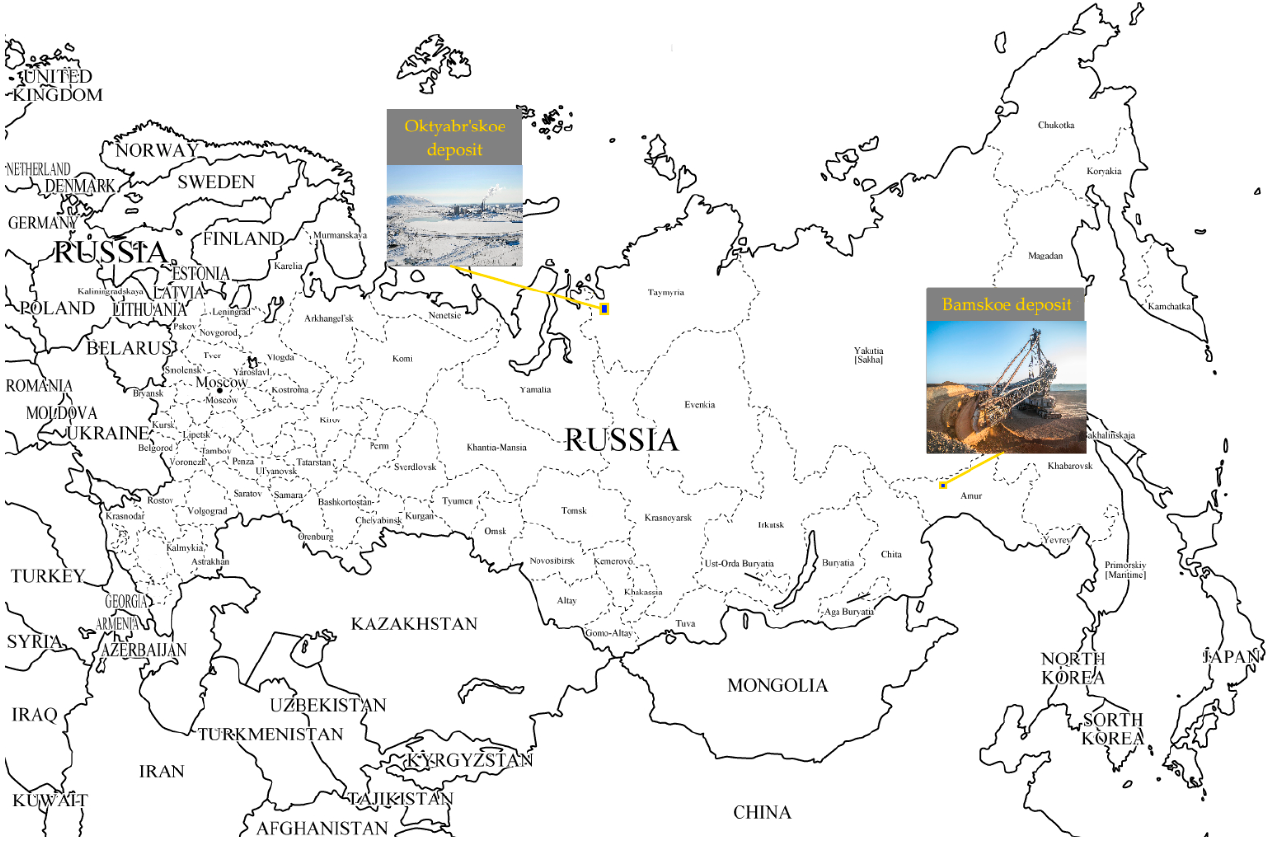
Figure 1. Location of the Bamskoe deposit and the Oktyabrskoye deposit. The samples were selected according to the following criteria: both samples are polymetallic ores. The ores of the Bamskoye deposit (Figure 2) are fine- and medium- grained from mainly vein disseminated ores.The copper-nickel ore of the Oktyabrskoye deposit (Figure 3), is coarse-grained from continuous veins, which is likely to have a significant effect on comminution performance and processing potential.